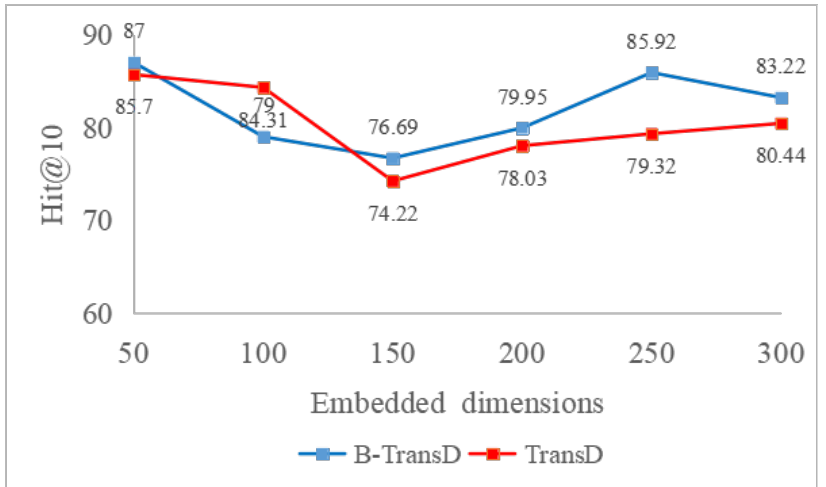
Figure 5. Hit@10 under different embedding dimensions.